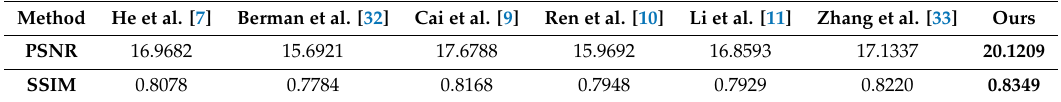
Table 5. Quantitative evaluation results of dehazing on